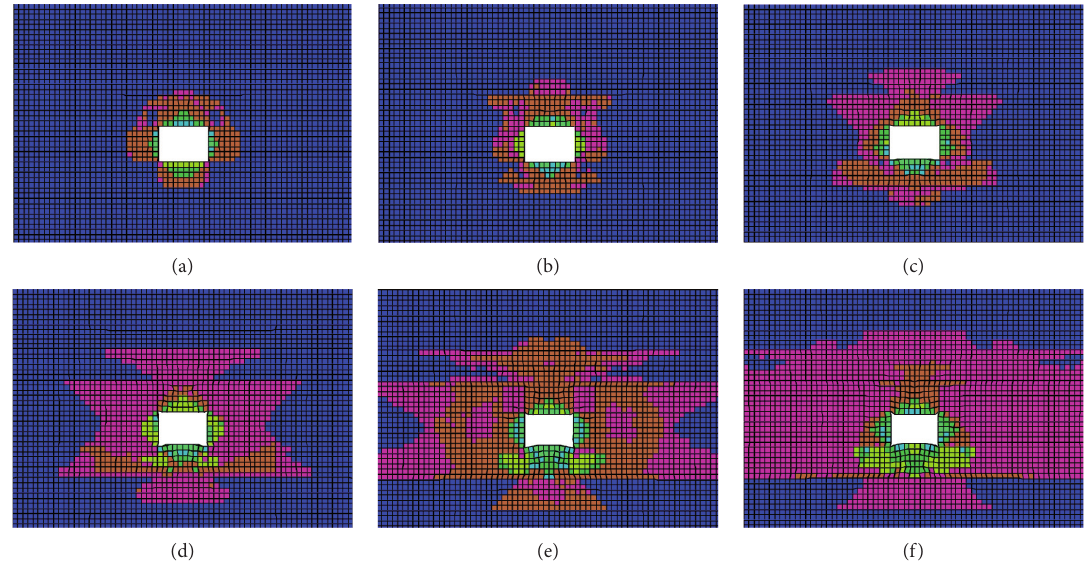
Figure 12: Distribution characteristics of plastic zone of roadway surrounding rock. (a) λ � 1.0; (b) λ � 1.3; (c) λ � 1.6; (d) λ � 1.9; (e) λ � 2.2; (f) λ � 2.5.